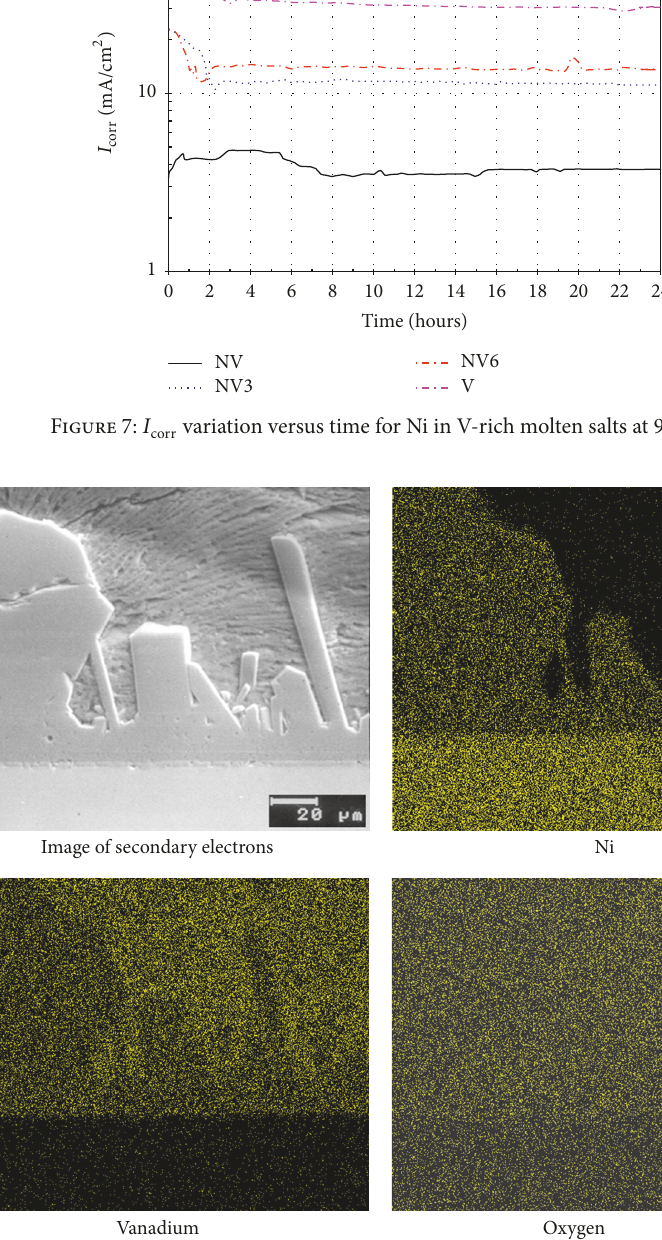
𝐼 corr values obtained from the potentiodynamic polarization curves and the LPR measurements. In the first case the information derived from the potentiodynamic polarization curves corresponds to the interaction of the bare Ni surface with the molten salts, and in the second case due to the corrosion process of Ni with corrosion products adhered to its surface (NiO and nickel vanadates). In the case of a bare Ni surface, the activation energies determined were